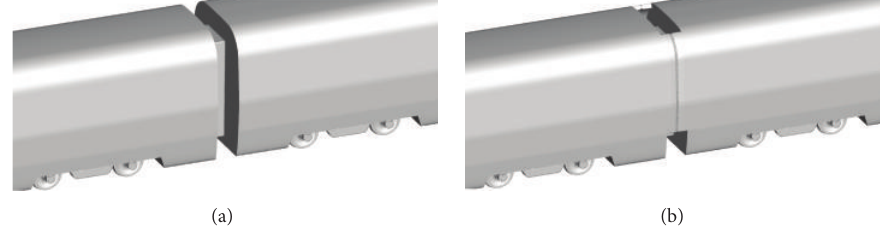
Figure 29: The geometric models of two types of inter-coach spacings: (a) Fd2 and (b)